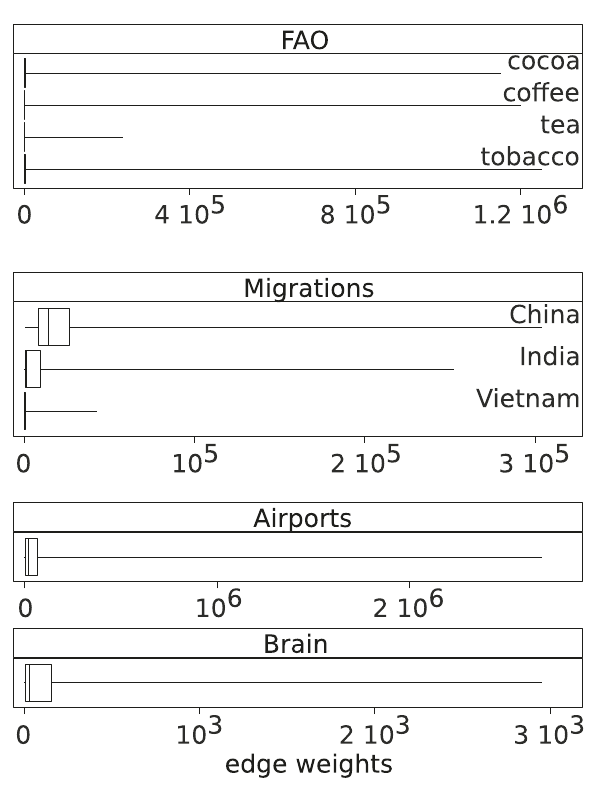
Fig. 5 Edge weights distributions of selected real-world networks. The number of nodes and edges of each network is speci fi ed in Table 1. Heterogeneity and scale vary across the datasets. The statistics of the boxplots are the fi rst and third quartiles of the weights distribution are displayed as the lower and upper hinges of the box, the line in the box represents the median, whiskers extend from the minimum to the maximum weight.